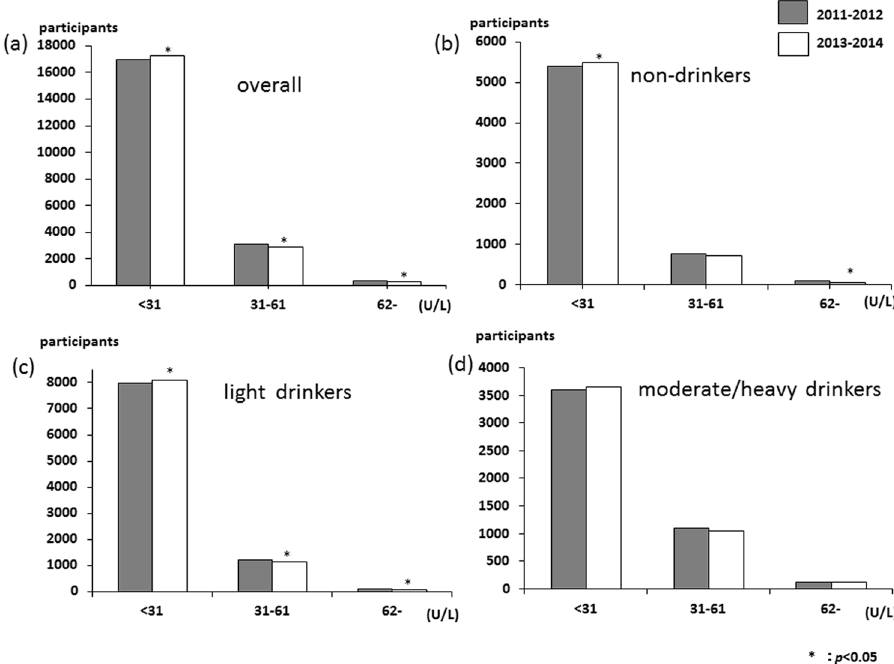
Figure 1. Distribution of serum AST ( a ) over all (n = 20395), ( b ) non-drinkers (n = 6264), ( c ) light drinkers (n = 9315), and ( d ) moderate/severe drinkers (n = 4816).